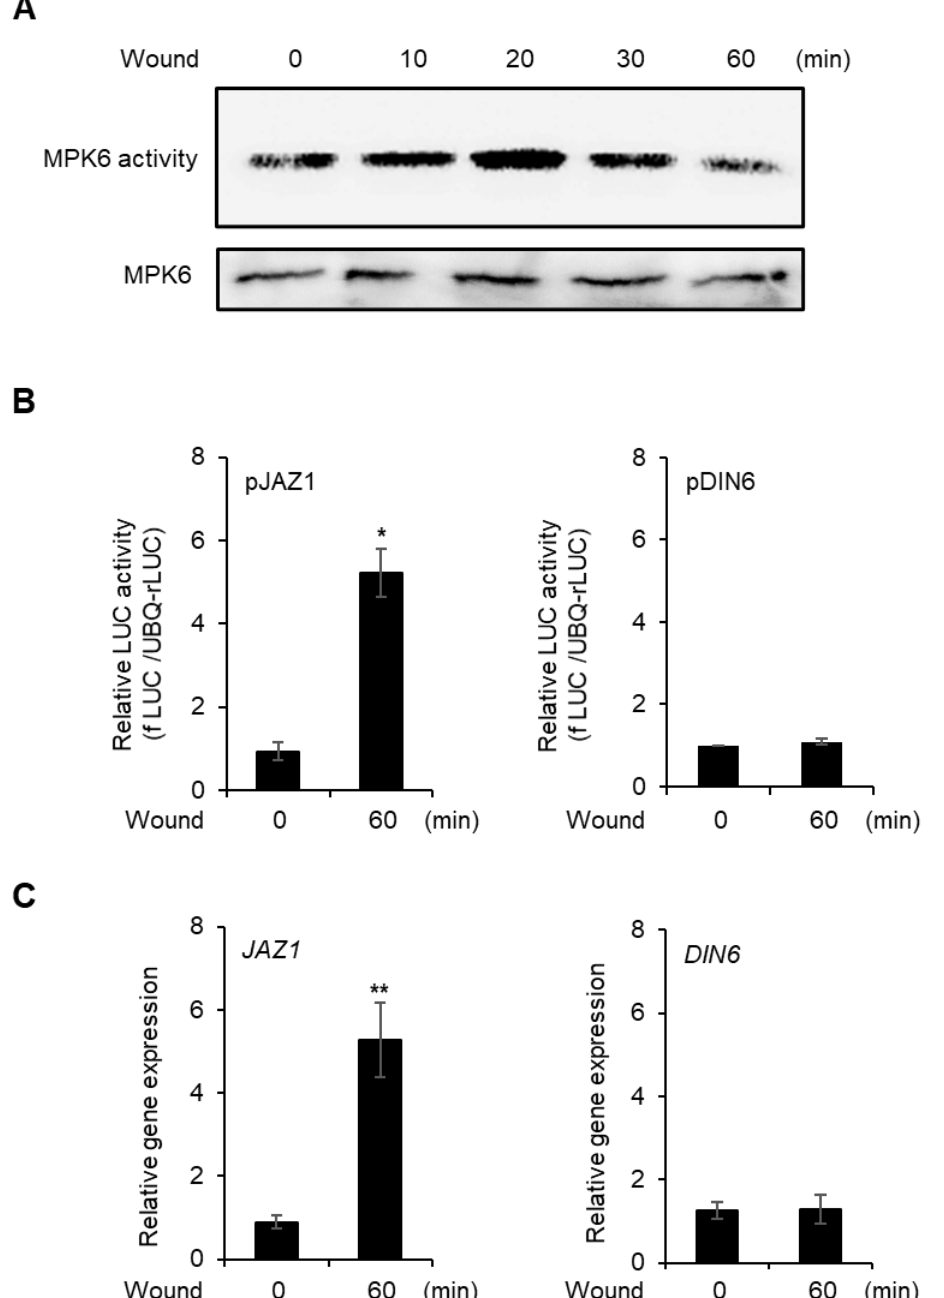
Figure 2. Response of vortex-induced wounding. ( A ) in vitro kinase activity of MPK6. After MPK6 was expressed in protoplast, vortex-induced wounding was carried out and time-dependent MPK6 activity was determined. Myelin basic protein was used as kinase substrate. The ( B ) promoter activities of JAZ1 and DIN6 after 60 min of wounding in AMPs. The promoter of JAZ1 and DIN6 was transfected to AMPs and incubated for 6 h. The AMPs were wounded and additionally incubated for 60 min and promoter activities were analyzed. Values are means ± SE of three repeats: * p < 0.01. The ( C ) gene expression of JAZ1 and DIN6 in wounded protoplasts. After isolation of AMPs, the protoplasts were incubated for 4 h without transfection for stabilization and wounded by vortex and incubated for 60 min. Total RNA was isolated from the AMPs and RT-qPCR was carried out. Values are means ± SE of three repeats: ** p < 0.001.